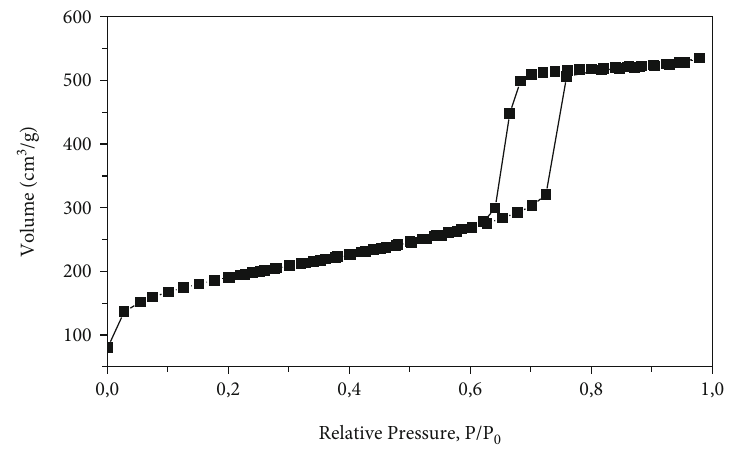
Figure 4: N adsorption-desorption isotherms at 77 K of catalyst sample 2